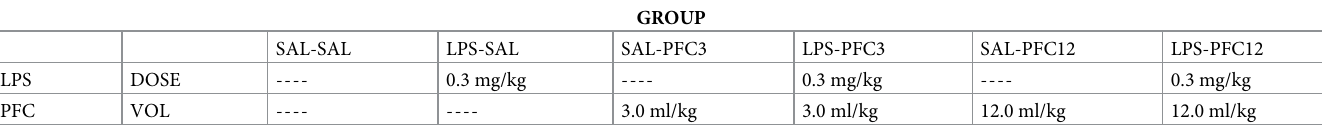
Table 1. Drug dosage and study groups.